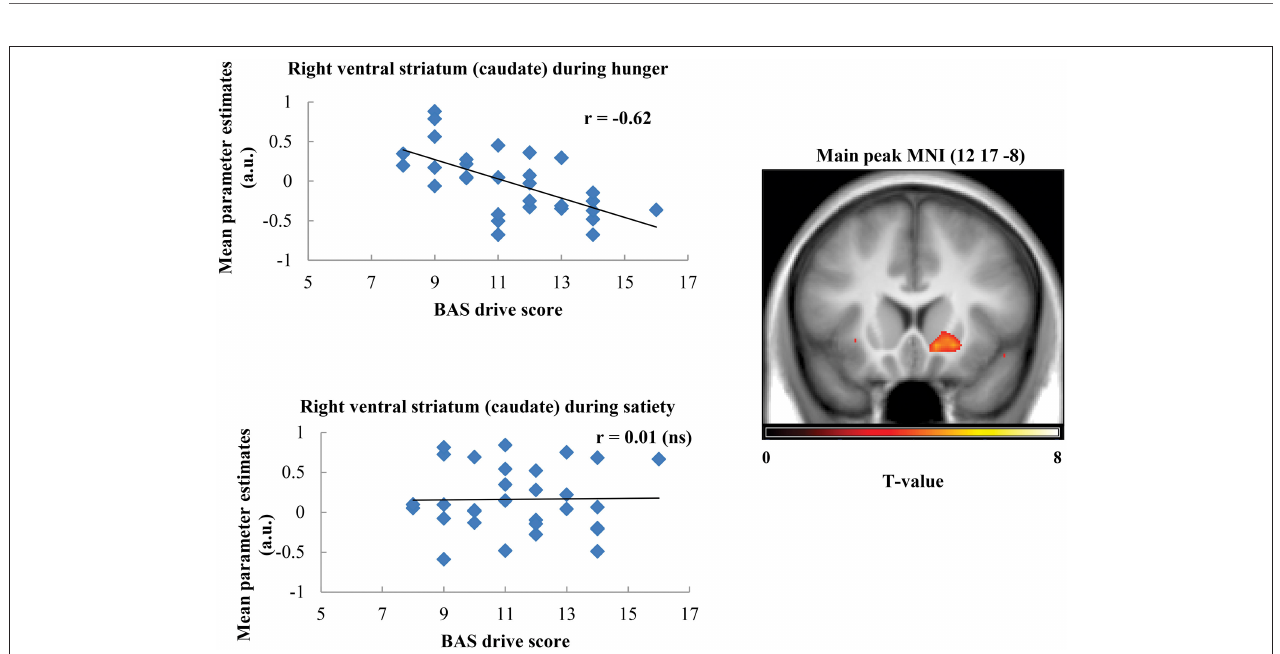
FIGURE 1 | Scatterplot of brain activation in response to oral calories (maltodextrin and sucralose minus sucralose) and reward sensitivity (BAS drive score) during hunger (significant) and satiety (not significant) in the right ventral striatum